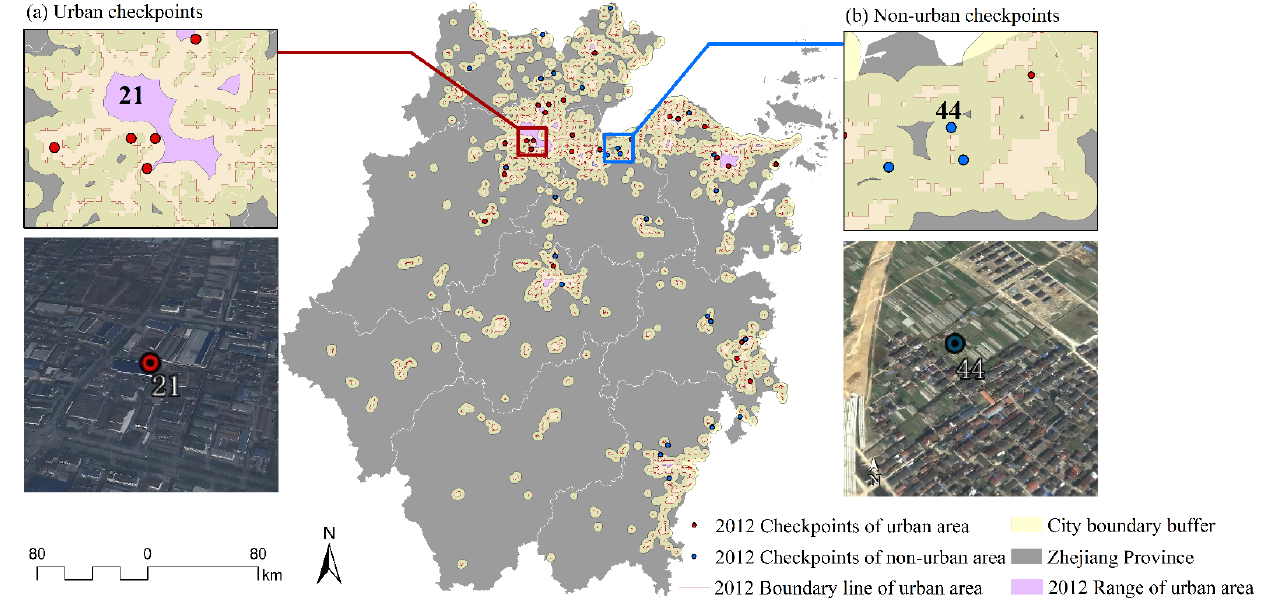
Figure 4. Buffer threshold analysis results obtained for the nighttime light-extracted urban areas in Zhejiang Province: ( a ) the location of the No.21 urban checkpoint in Google Earth; ( b ) the location of the No.44 non-urban checkpoint in Google Earth. Table 1. Accuracy test results of the extracted urban areas in Zhejiang Province.